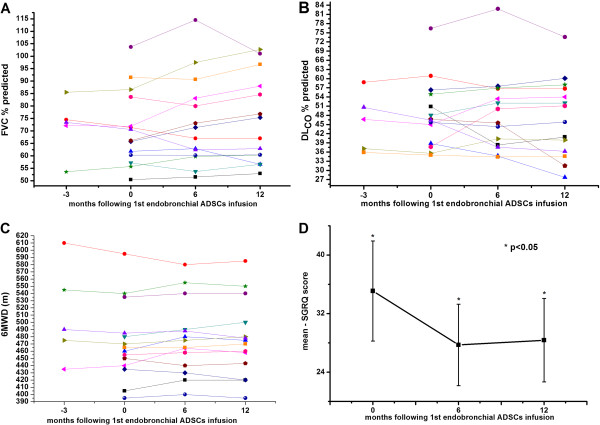
Exploratory efficacy end-points before and after endobronchial infusion of adipose derived stromal cells-stromal vascular fraction (ADSCs-SVF). A. Forced vital capacity (FVC)% pred. over time for each subject. Each line represents measurements made in a single subject. A time point 0 months indicates when first endobronchial infusion of the ADSCs-SVF was performed. As depicted, there were no statistically significant alterations between baseline and after 6 and 12 months following 1st endobronchial infusion. A time point −3 months indicates period of time prior treatment initiation. B. Diffusion lung capacity for carbon monoxide (DLCO)% pred. over time for each subject. Each line represents measurements made in a single subject. As depicted, there were no statistically significant alterations between baseline and after 6 and 12 months following 1st endobronchial infusion. A time point 0 months indicates when first endobronchial infusion of ADSCs-SVF was performed. A time point −3 months indicates period of time prior treatment initiation. C. 6-minute walking distance (6MWD) over time. As depicted, there were no statistically significant alterations between baseline and after 6 and 12 months following 1st endobronchial infusion of the ADSCs-SVF. A time point −3 months indicates period of time prior treatment initiation. D. Saint George’s Research Questionnaire (SGRQ) score over time. A time point 0 months indicates when first endobronchial infusion of the ADSCs-SVF was performed. As depicted, there was a statistically significant decline between baseline (0 months) and after 6 and 12 months following 1st endobronchial infusion. *p<0.05.